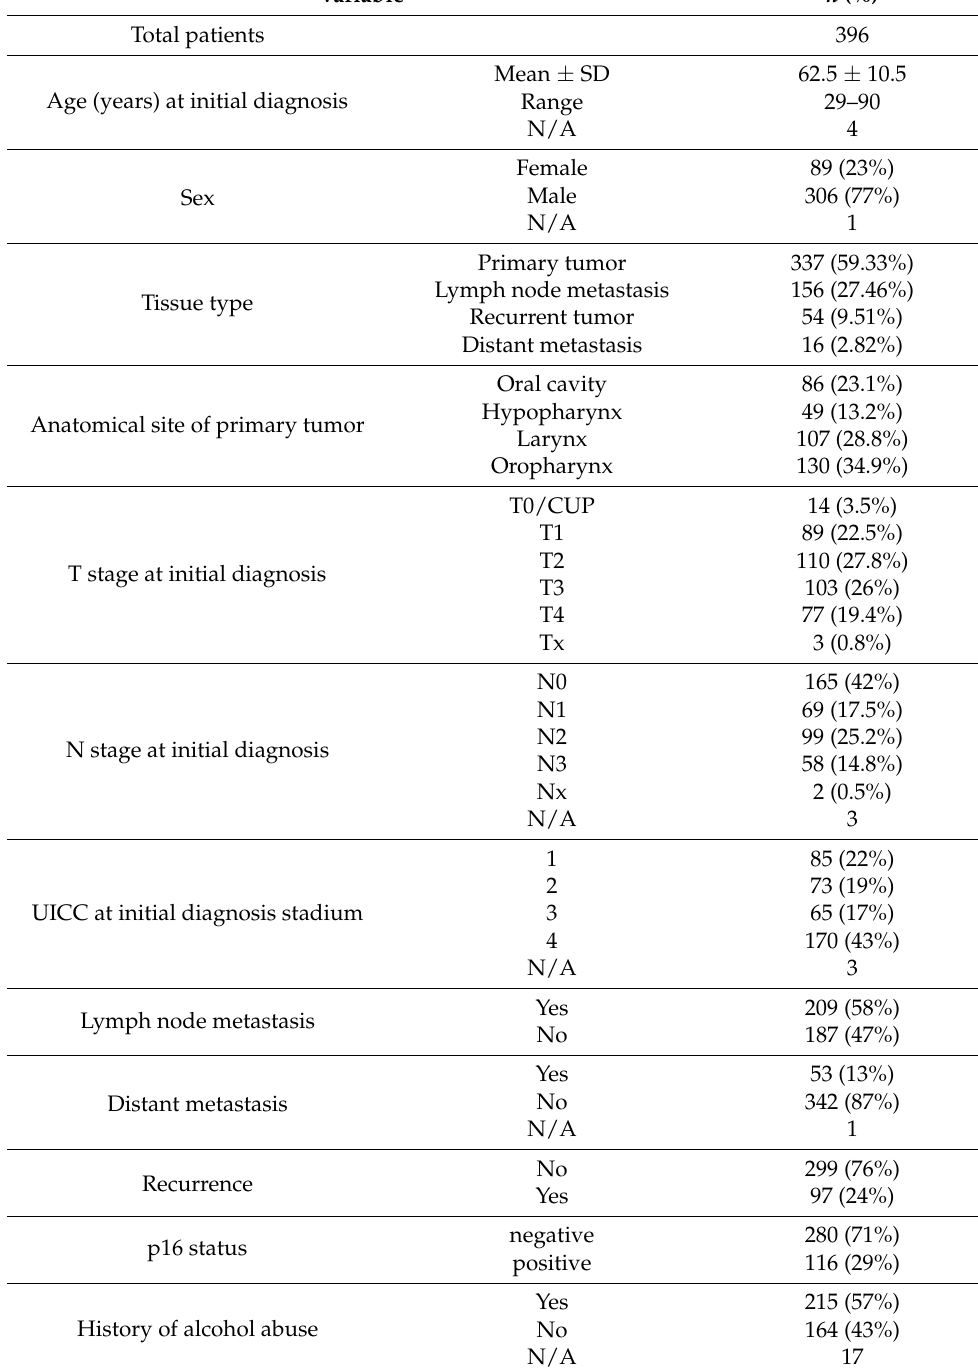
Table A1. Overview of clinicopathological characteristics of our HNSCC